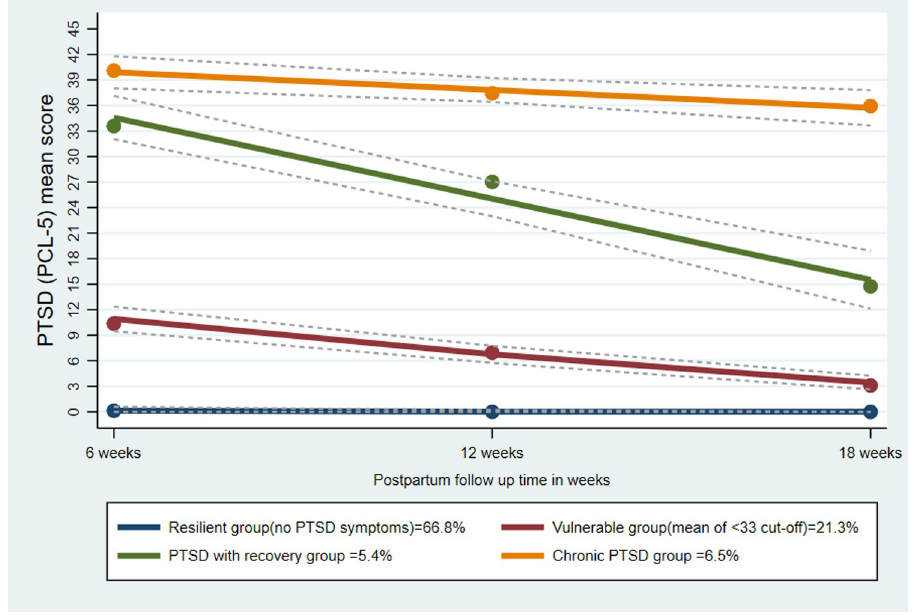
Fig 2. Trajectories of PTSD symptoms among postpartum women, Northwest Ethiopia,